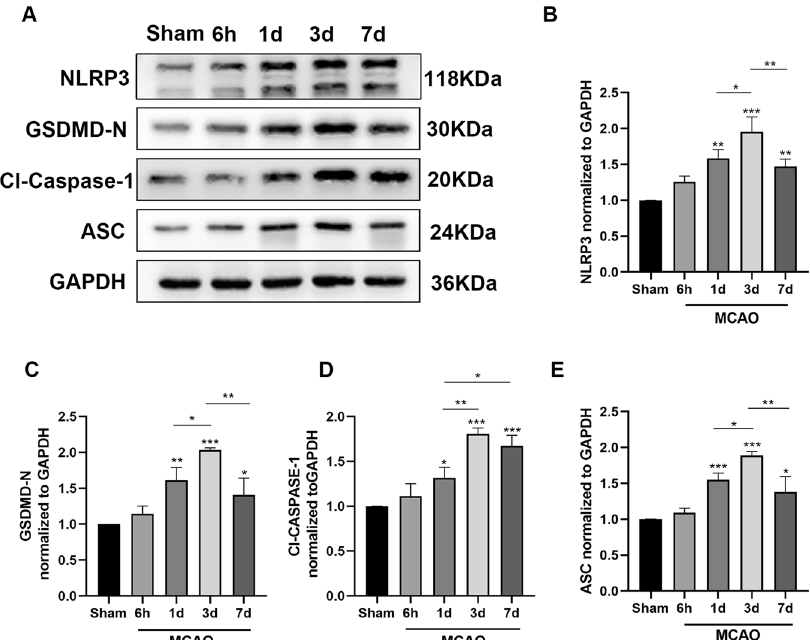
Fig. 1 NLRP3 in fl ammasome expression was increased after cerebral ischemia/reperfusion injury. A – E Representative western blotting images and analysis of NLRP3, GSDMD-N, cleaved caspase 1 (Cl-Caspase-1), and ASC levels ( n = 4). Cerebral ischemia/reperfusion injury substantially increased the levels of NLRP3, GSDMD-N, Cl-Caspase-1, and ASC, with the greatest level seen on day 3 following reperfusion. * P < 0.05, ** P < 0.01, *** P < 0.001 versus the sham